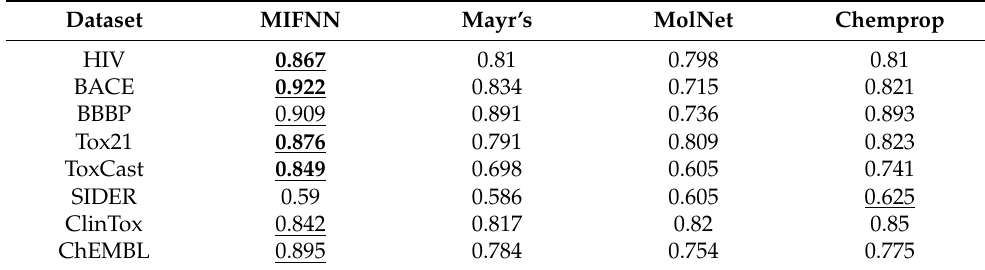
Table 2. Comparison of AUC values for MIFNN and baseline models (underlined values are maxi- mum values; bolded values are significantly higher than those of other